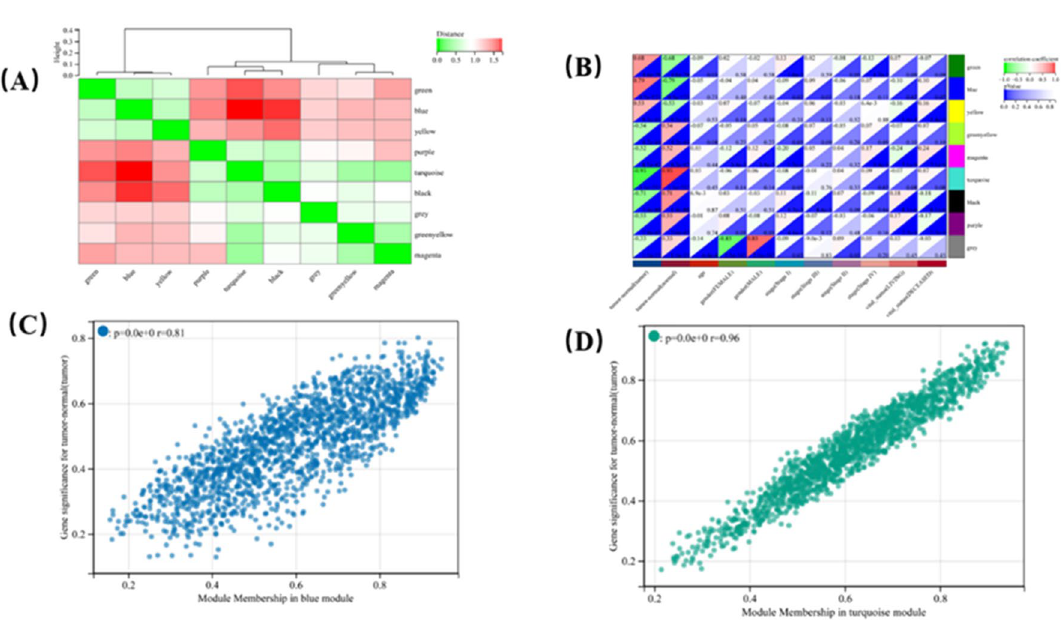
Figure 6. WGCNA of DEGs and identification of hub genes. ( A ) Module eigengene (MEs) heatmap. ( B ) Heatmap of the correlation between module eigengenes (MEs) and clinical characteristics of patients with KIRC. Each cell contains the correlation coefficient and P -value. ( C , D ) Scatter plots of GS score and MM (see the ‘Materials and methods’ section) for genes in the ( C ) blue and ( D ) turquoise